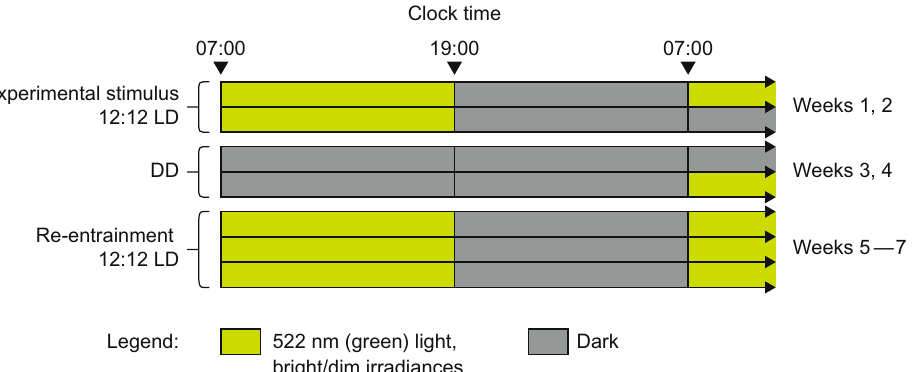
Figure 1. The experimental protocol for mouse Groups 1 and 2. The irradiance levels for the bright and dim experimental conditions are provided in Table 1. During re-entrainment, the mice were exposed to the same treatment photophase irradiances they experience during the initial 2 weeks of experimental 12:12 LD pattern; DD, 24 h of